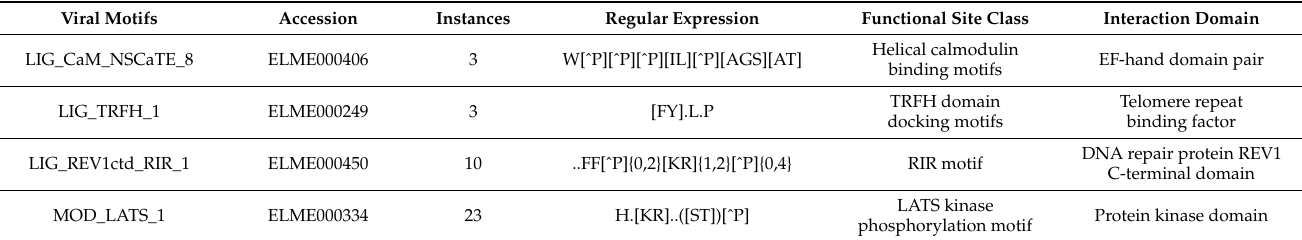
Table 1. List of unique SARS-CoV-2 Omicron SLiMs.